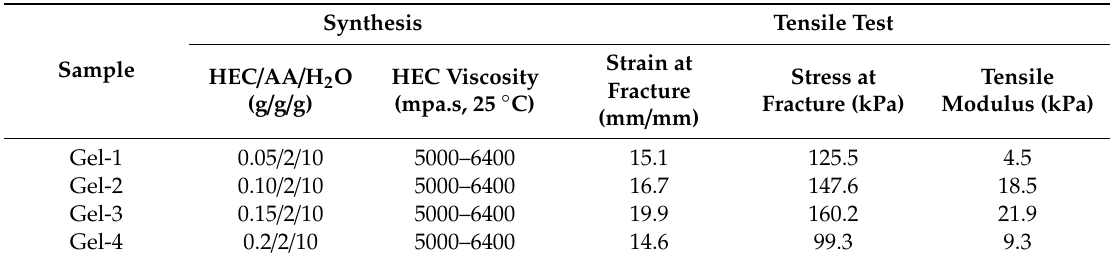
Table 1. Tensile properties of the Agar / PAA / HEC DN hydrogels with di ff erent HEC contents.